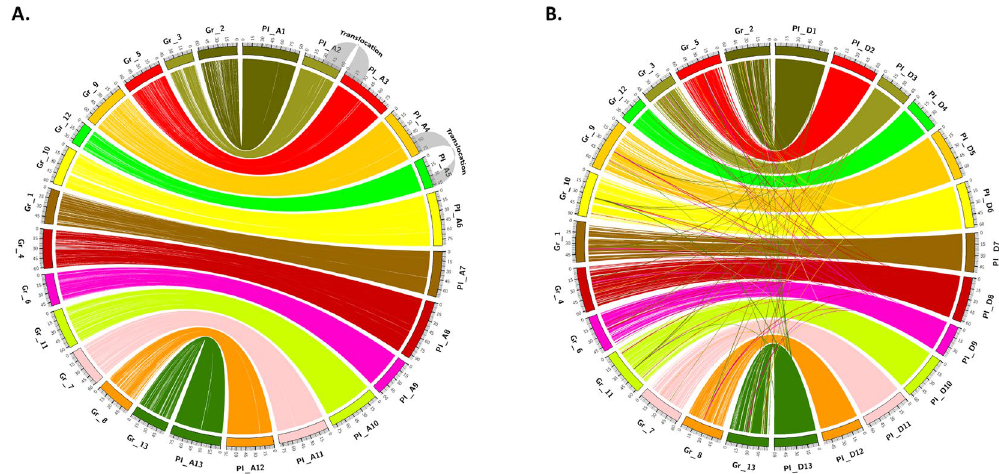
Figure 1. ( A ) Alignment of the G. hirsutum A-sub genome physical map pseudomolecules (PI) to the Gossypium raimondii JGI reference genome assembly (Gr). Two known translocations (A2/A3 and A4/A5) in the cotton tetraploid A-sub genome are highlighted by the outer grey links on the ideograms. ( B ) Alignment of the G. hirsutum D-sub genome physical map pseudomolecules (PI) to the Gossypium raimondii JGI reference genome assembly (Gr). Colored ribbons connect contiguous blocks of at least 6 BAC-end sequences with at least 95% sequence identity between the BAC-map contigs and the reference genome